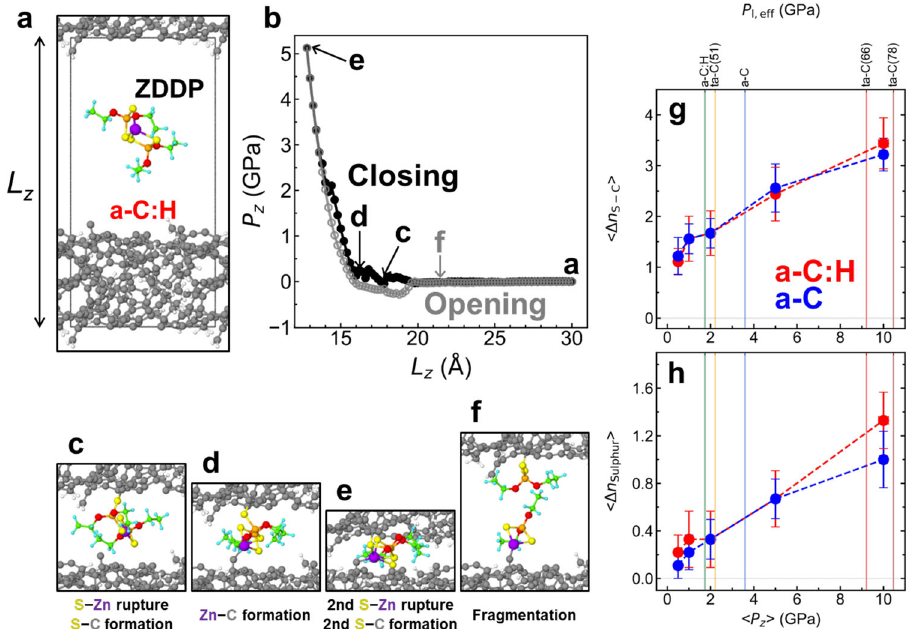
Fig. 6 Quasi-static contact-closing/opening simulations for a-C:H with ρ = 2.0 g cm − 3 and CH = 20 at% and a-C with ρ = 2.0 g cm − 3 in contact with a ZDDP molecule using DFTB3 quantum chemical calculations. a Initial atomic con fi guration for a representative a-C:H system. b Evolution of the normal pressure P z as a function of the z system dimension L z during the closing (black circles) and opening process (grey circles). c – f Evolution of atomic con fi gurations for a representative trajectory of a-C:H. For C and H, different colours are assigned between the surface atoms (grey for C and white for H) and atoms in the ZDDP molecule (green for C and cyan for H). Zn, S, P and O are represented by violet, yellow, orange, and red spheres, respectively. The (cid:3) (cid:4) L – f are indicated by labels in b . g Averaged numbers of S − C bonds Δ n formed (cid:3) (cid:4) z values and corresponding normal pressures of the snapshots c S (cid:3) C between ZDDP sulphur and DLC carbon atoms as well as h sulphur atoms released from ZDDP n Sulphur to the DLC after reopening the contact as a function of the contact pressure P z for a-C:H with ρ = 2.0 g cm − 3 and C H = 20 at.% (red) and a-C with ρ = 2.0 g cm − 3 (blue). The error bars represent standard error of the means. The vertical lines mark the effective local contact pressures P l ; eff for the fi ve experimental coatings (Fig. and form and ZDDP ’ s decomposition starts with the loss of alkyl Bond-breaking and -forming processes in ZDDP are strongly groups 34 . On surfaces, breaking of Zn − S bonds is the fi rst affected by the contact pressure but not by the chemical structure observed reaction because the formation of S − C bonds with C of the DLC surfaces. Figure 6g shows the contact-pressure atoms on the surface prevents the reformation of the Zn − S dependence of chemical reactions of ZDDP squeezed quasi- bonds. statically between two a-C and two a-C:H surfaces. The values